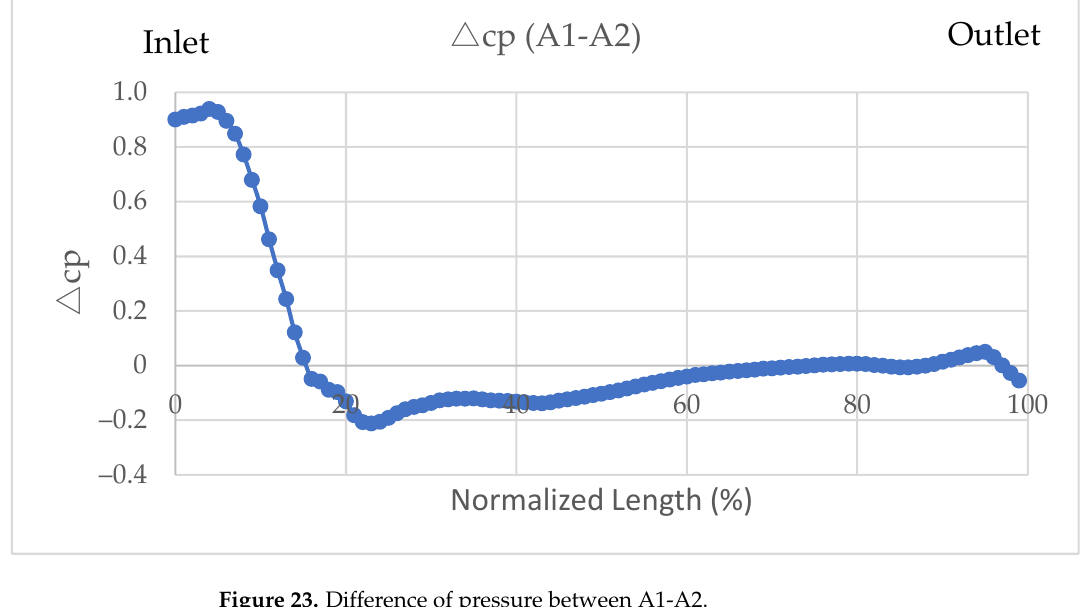
Figure 23. Difference of pressure between A1-A2.